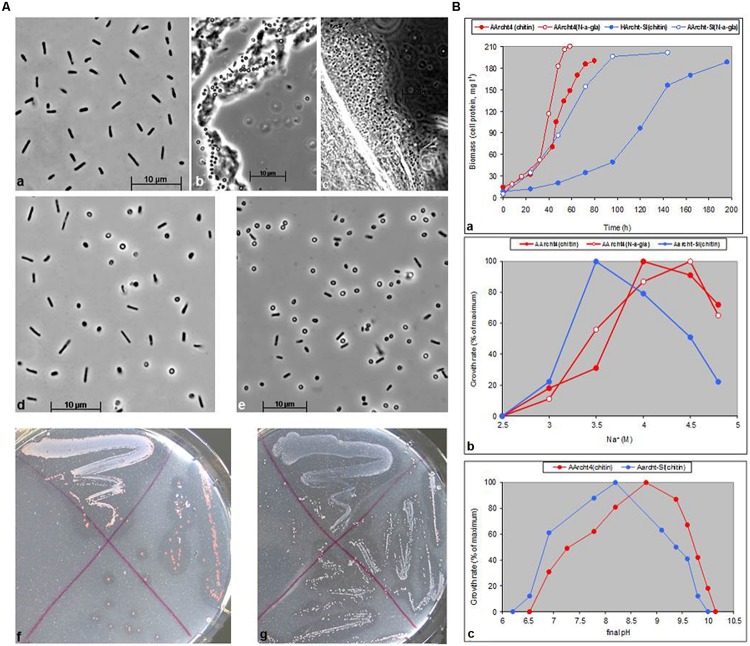
(A) Cell and colony morphology of natronoarchaea grown on chitin at 4 M Na+, pH 9.3–9.5. (a–c) AArcht4 cells in liquid culture; (a) free cells, (b,c) cells colonizing amorphous and crystalline chitin. (d,e), AArcht-Sl cells in liquid culture and in colonies. (f,g) Archt4 and AArcht-Sl colonies grown on plates with amorphous chitin. (B) Growth dynamics (a) and influence of sodium (b), and pH (c) on growth of natronoarchaeal isolates on amorphous chitin or N-acetyl-glucosamine as a sole substrates.